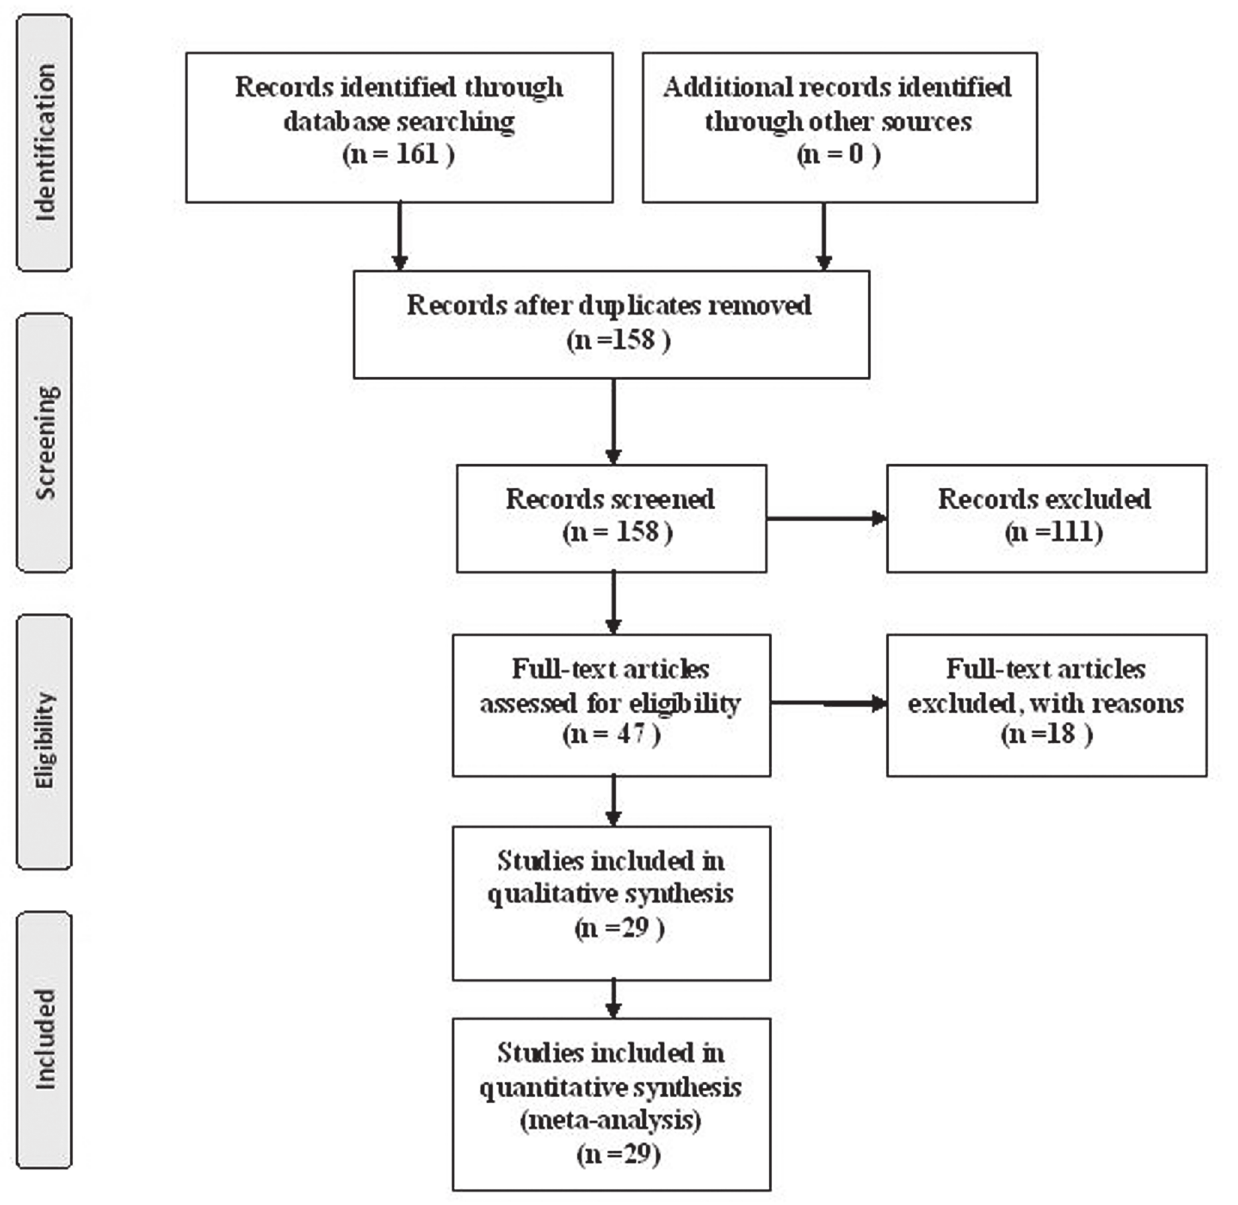
Figure 1. Flow diagram of assessment of studies identified in the